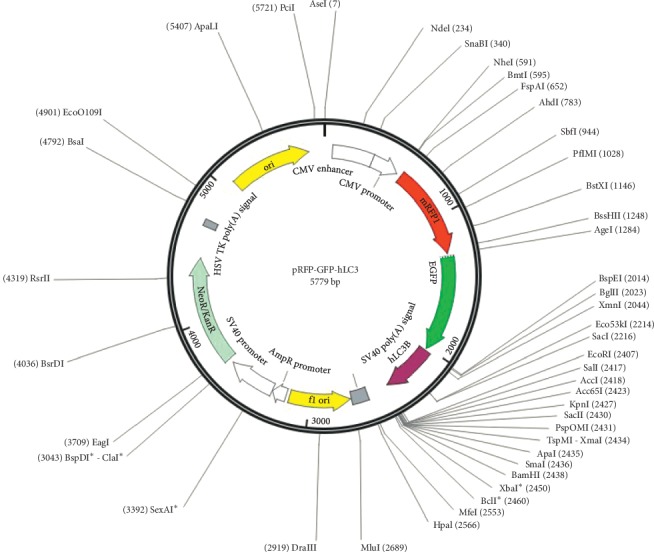
GFP-RFP-LC3 plasmid.